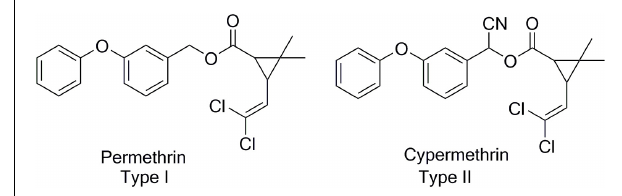
FIGURE 1 | Structure of type I and type II pyrethroids.